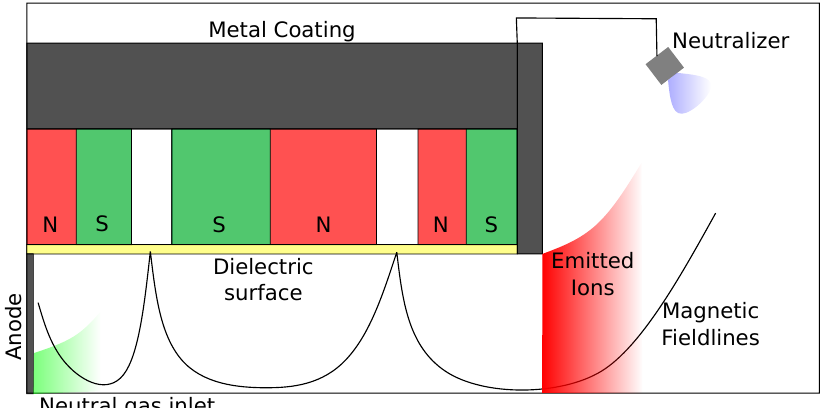
Figure 1. Schematic view of a three-stage HEMP-Thruster. The cylinder is cut horizontally along the cylinder’s axis of